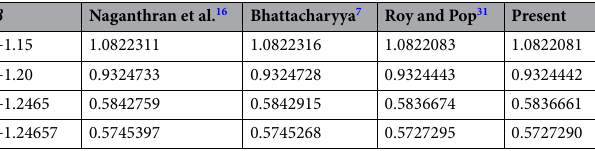
Table 3. Comparison of f ′′ ( 0 ) for various values of K = 0, Gr = 0, H = 0, Nr = 0, Ec = 0, M = 0 and s = 0.